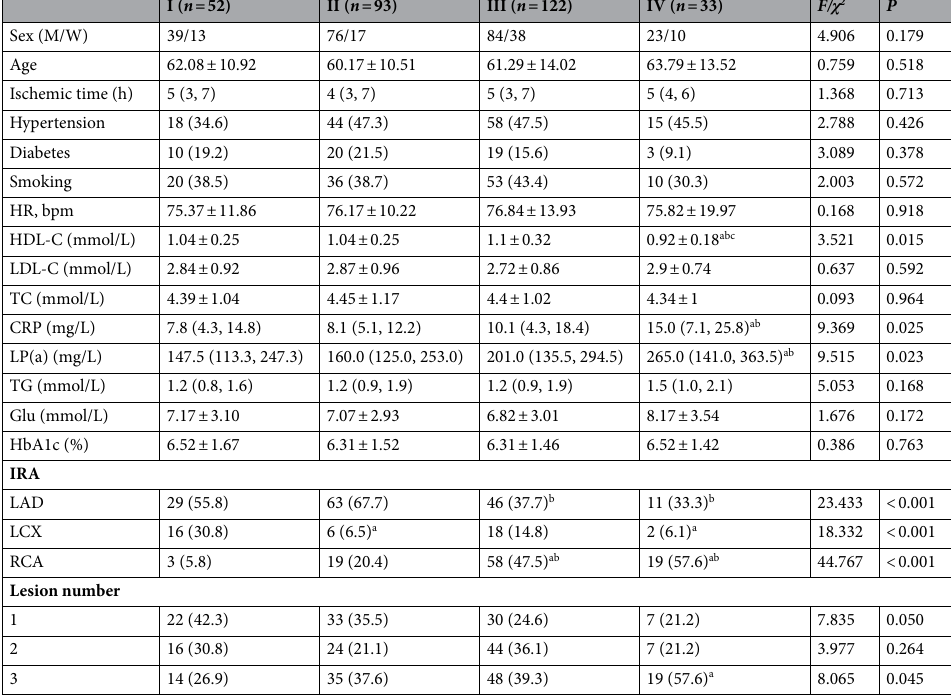
Table 1. Baseline characteristics of the participants. a vs. Grade I, b vs. Grade II, c vs. Grade III, P < 0.05. W women, M men, HR heart rate, CRP C-reactive protein, Glu blood glucose, IRA infarct-related artery, RCA right coronary artery, LAD left anterior descending coronary artery, LCX left circumflex coronary